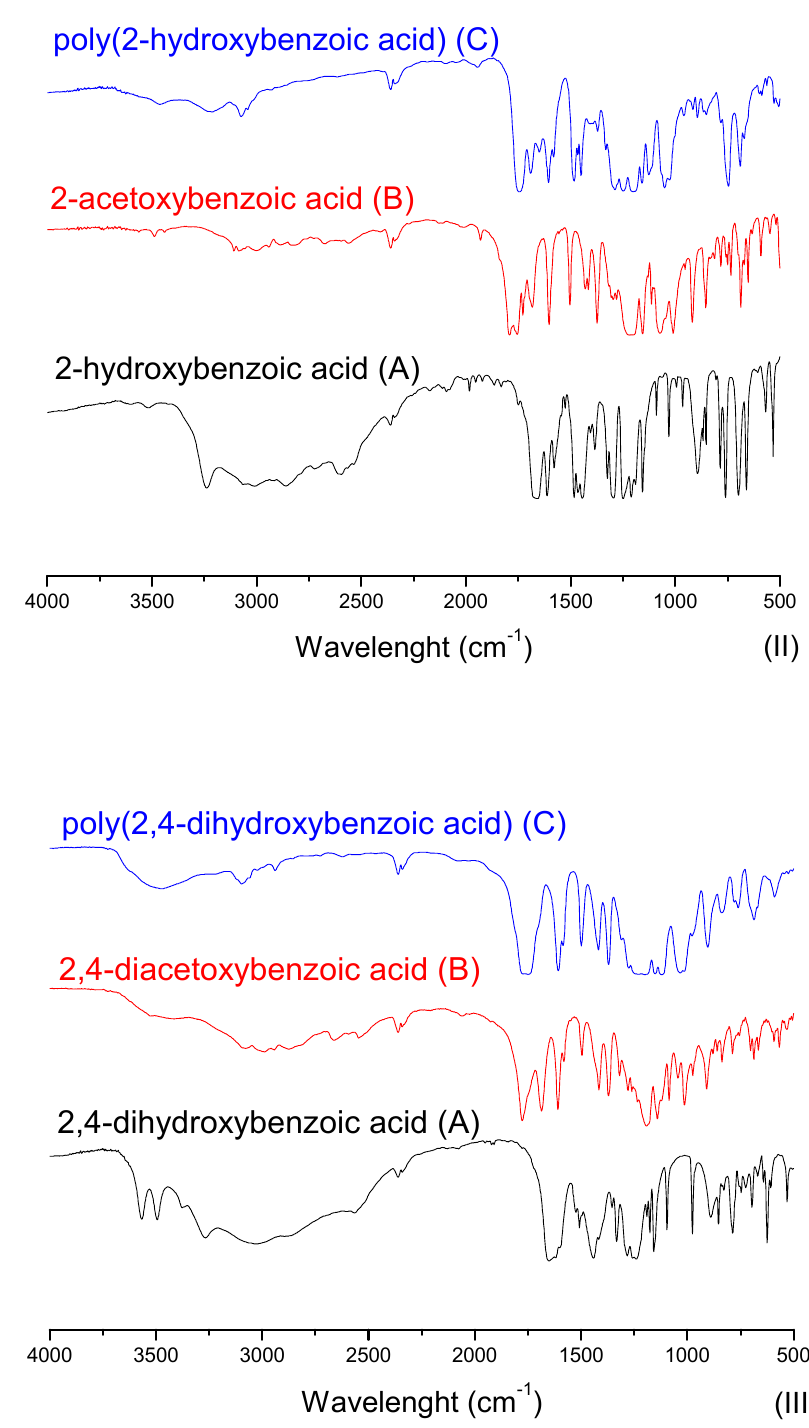
Figure 7. Aromatic acids, acetylated and polymer products FTIR spectra.